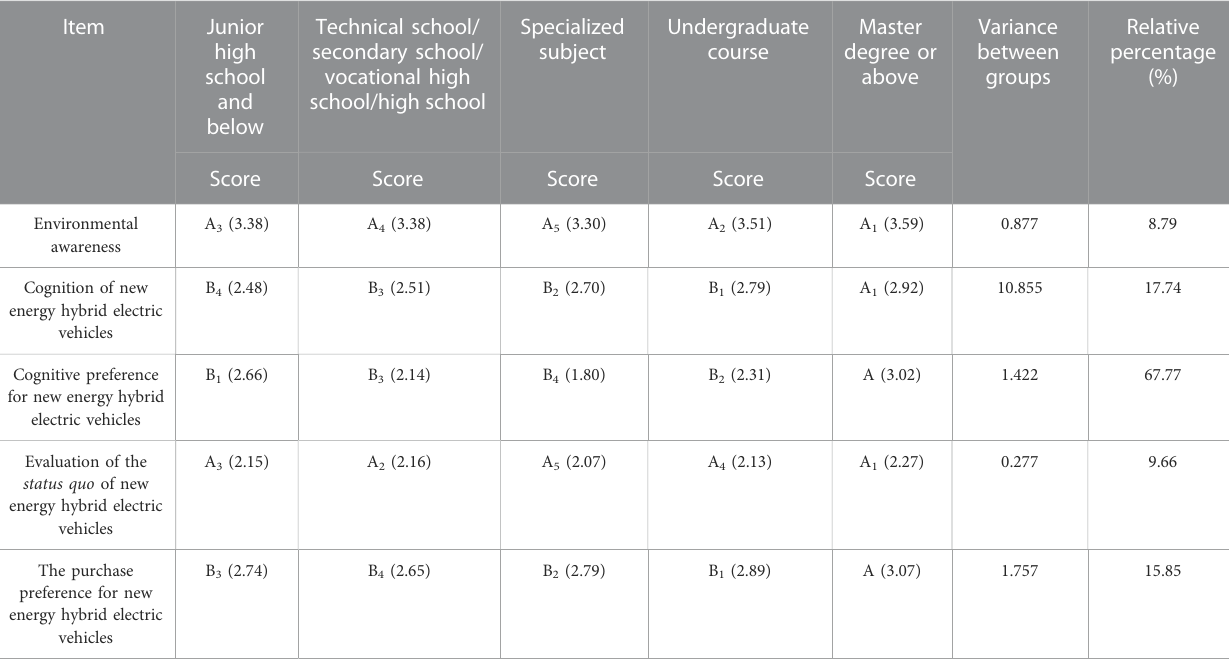
TABLE 8 Test results and ranking of different educational